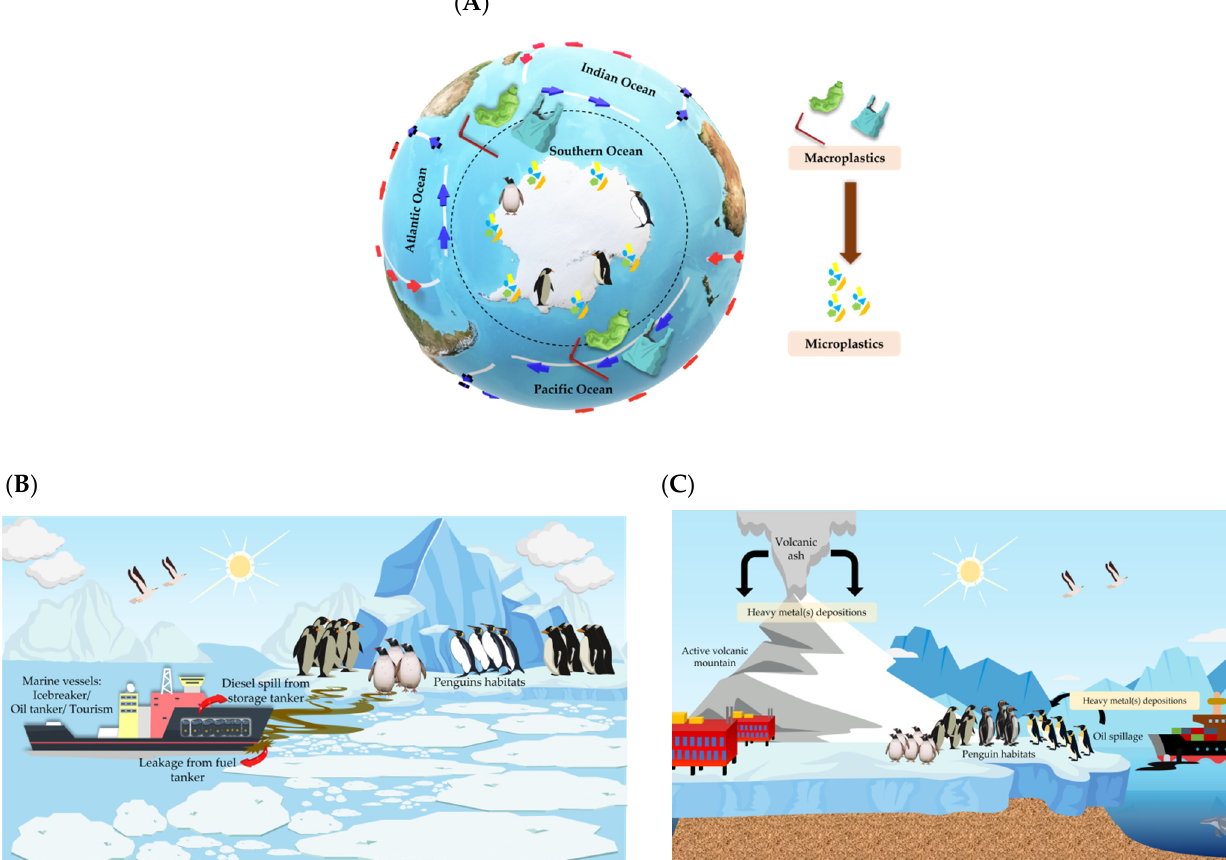
Figure 3. Sources of ( A ) microplastics, ( B ) diesel and ( C ) heavy metals pollution in Antarctica and the effects towards penguins. Table 2. Pollution incidents and their effects on penguins in Antarctica.